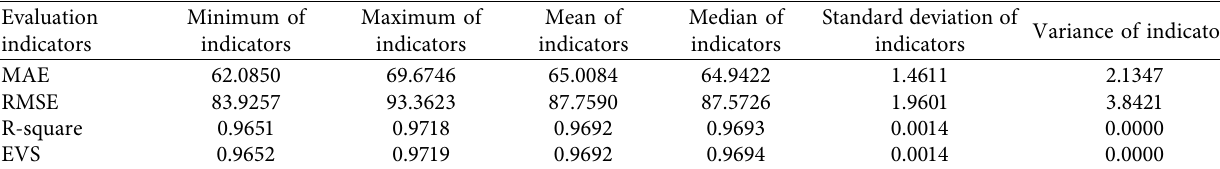
Table 5: Predictive performance evaluation profiles of LHV for the testing phase by LHV-IVE.